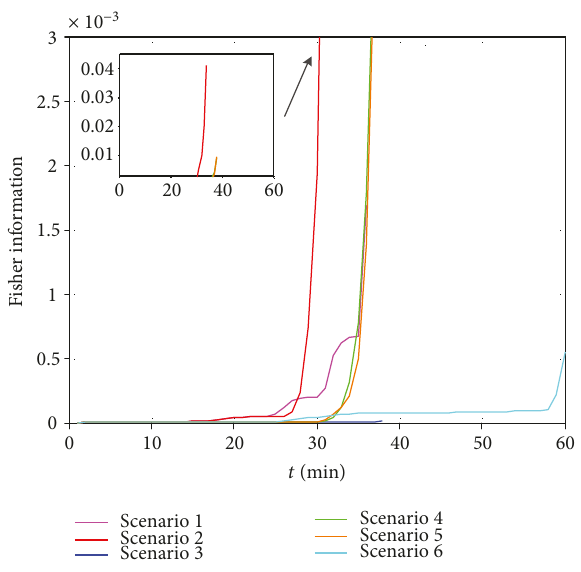
Figure 12: Fisher information of the scenarios.